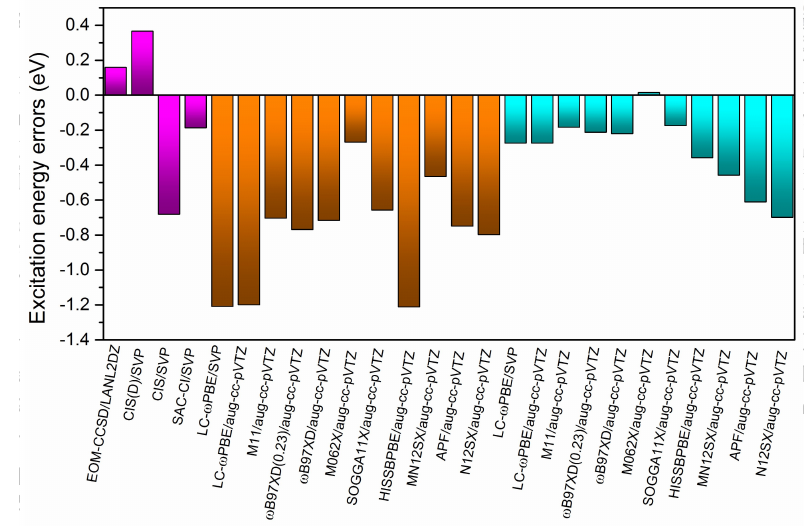
Figure 4. The calculated excitation energy errors relative to the EOM-CCSD/SVP benchmark result for the lowest triplet excited state. The purple, brown, and blue regions represent the results of the ab initio, full TDDFT, and TDA-TDDFT methods,